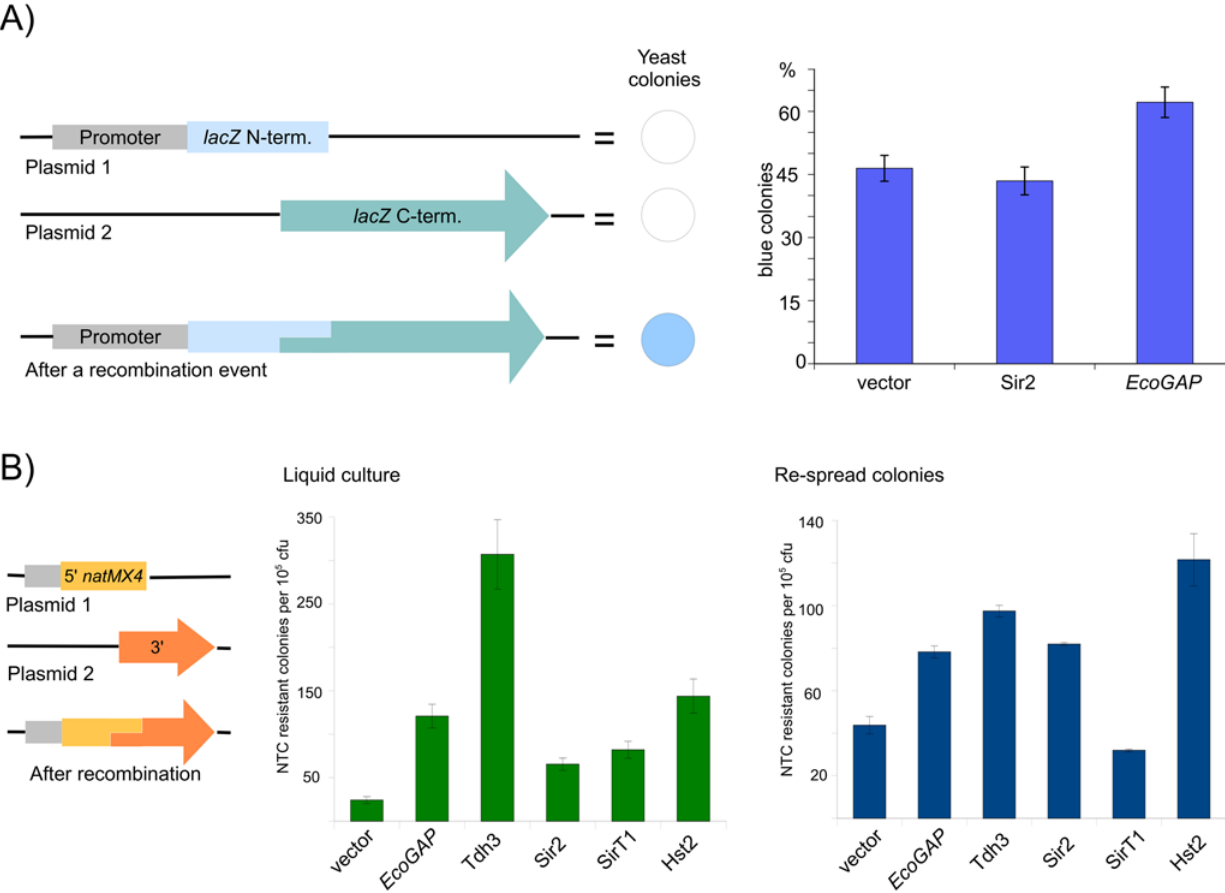
Figure 3. Overexpression of GAPDH paralogues increases plasmid recombination frequency. (A) Principle of the lacZ -based plasmid recombination assay (left panel). Plasmid 1 carries a yeast promoter that drives expression of the N-terminal part of ß-galactosidase, and plasmid 2 encodes the C-terminal part. The ß-galactosidase fragments overlap by 564 bp. When the plasmids recombine, a functional lacZ expression vector is reconstituted and yeast colonies turn blue in a membrane-based X-GAL assay. (Right panel) The vectors encoding for both ß-galactosidase fragments were transformed in triplicate with an empty vector, p( HIS3 )- SIR2 , or p( HIS3 )- Eco GAP and were plated on nylon membranes. Cells were grown at 30 u C for 4 days, assayed for ß-galactosidase, and air-dried in the dark. Blue and white colonies were counted. Error bars indicate the standard deviation. (B) natMX4 -based recombination assay (left panel). Similar to the lacZ assay, two plasmids encoding for overlapping fragments of the natMX4 marker cassette were transformed into yeast. When the plasmids recombine, a functional natMX4 cassette is reconstituted, allowing growth on NTC- containing media. Yeast containing 5 9 and 3 9 natMX4 plasmids was transformed along with a third plasmid encoding the indicated protein (middle panel). Fifty colonies from each transformation were pooled, grown overnight, and spread on plates in triplicate with or without NTC. The Y axis indicates the number of NTC resistant colonies per 10 5 cfu. Results are also shown with colonies directly re-spread on the NTC media, without re- growth in liquid media (right